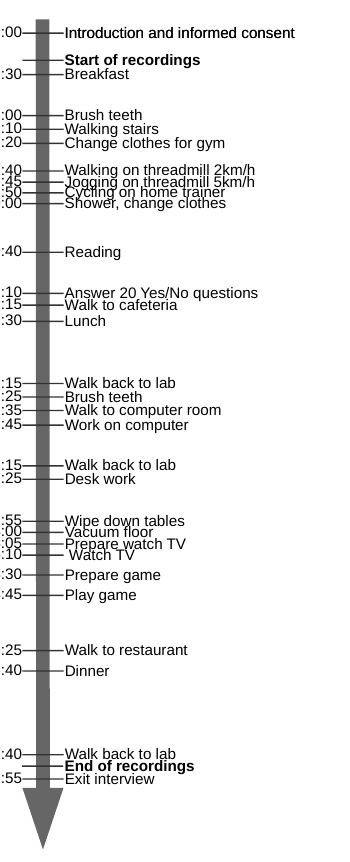
Figure 4: Protocol of the daily activity study.